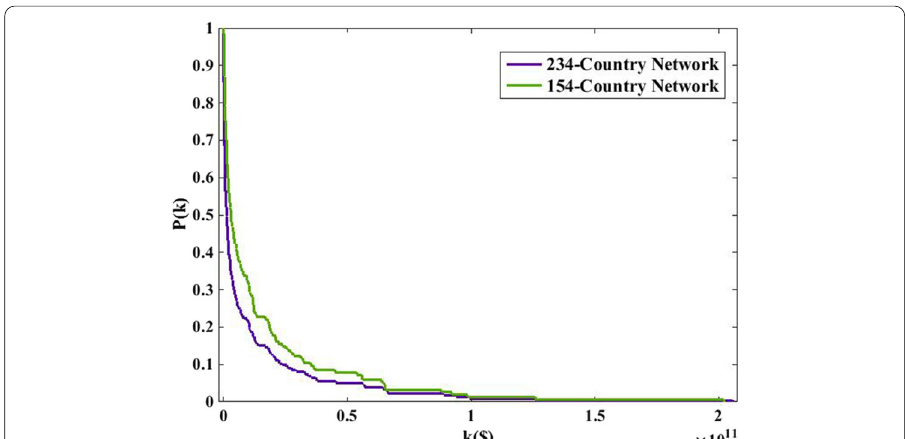
Fig. 3 Degree distribution in 234- and 154-country networks Degree distribution in 234-country and 154-country networks. The dark-colored plot represents the degree distribution in the 234-country network; the network of trading partners. The bright-colored plot shows the degree distribution in the 154-country network; the network of reporting countries. The vertical axis shows the fraction of countries having degrees more than or equal to k and horizontal axis represents the degree of countries in the import network of food and live animals as a representative